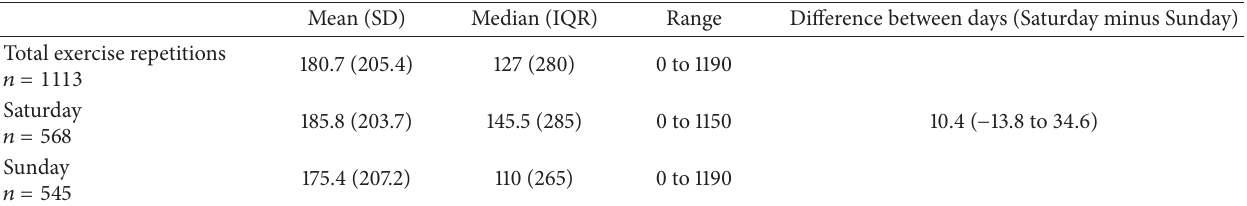
Table 2: Amount of exercise repetitions completed in each Weekend Warrior class.